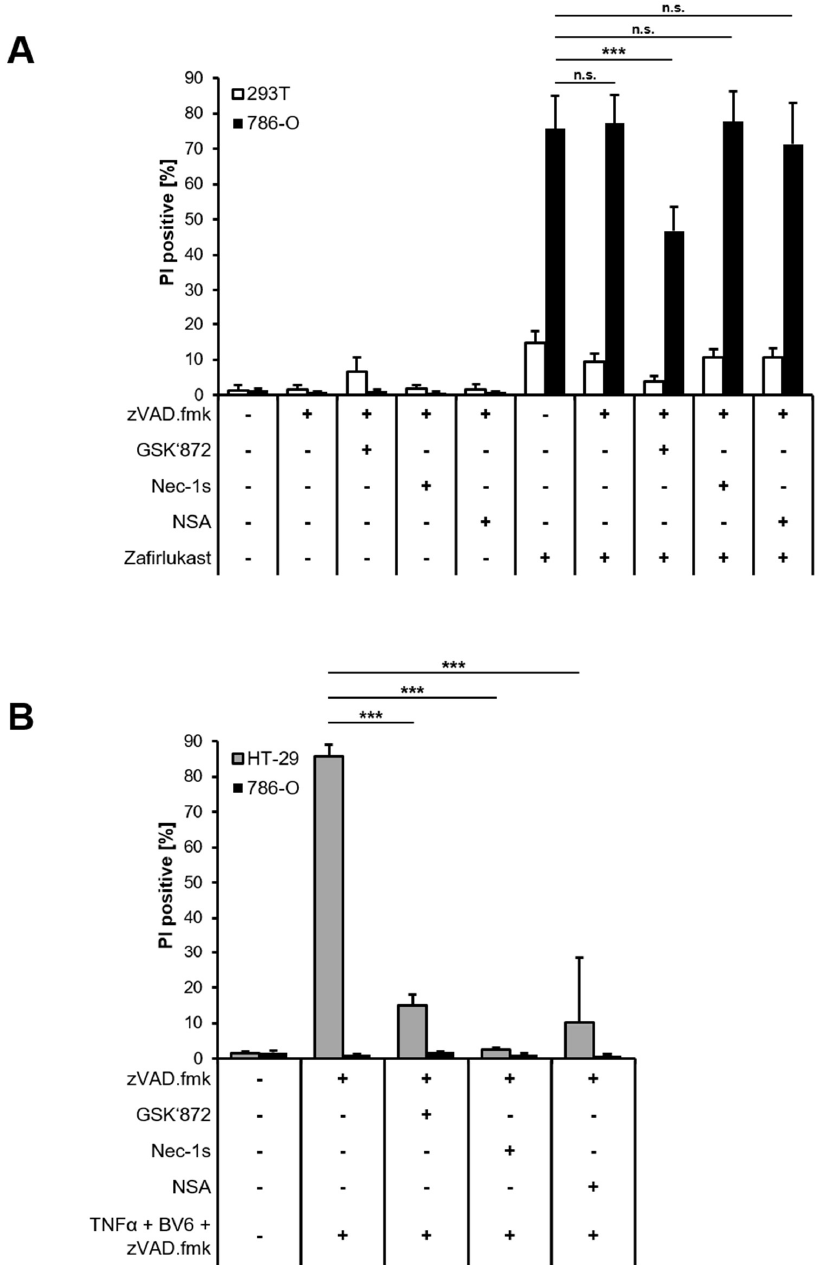
Figure 3. Zafirlukast does not trigger caspase-dependent apoptosis or necroptosis. ( A ) 786-O and 293T cells were pre-treated with the pan-caspase inhibitor zVAD.fmk (20 µM), the RIPK3 inhibitor GSK’872 (20 µM), the RIPK1 inhibitor Nec-1s (25 µM) or the MLKL inhibitor NSA (1 µM), followed by treatments with DMSO or 100 µM zafirlukast for 24 h, after which cell death was determined by quantifying PI uptake. Data are presented as percentage of PI-positive cells and mean and SD of three independent experiments performed in triplicate are shown. *** p < 0.001, n.s.: non-significant; ( B ) As in ( A ), but HT-29 and 786-O cells were treated with the indicated inhibitor/zafirlukast combinations. Data are presented as percentage of PI-positive cells and mean and SD of three independent experiments performed in triplicate are shown. *** p <